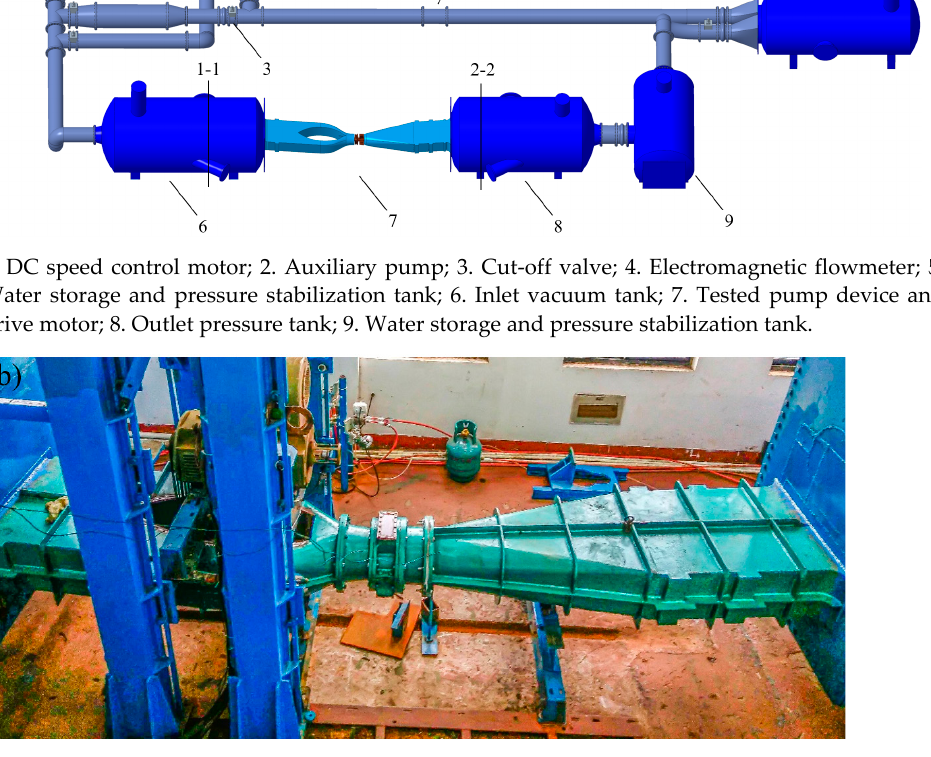
Figure 4. Experimental setup: ( a ) schematic diagram of the test bench and ( b ) photo of the tested pump system.